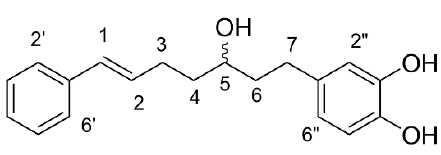
Figure1. Thechemicalstructureofcompound 1 Figure 1. The chemical structure of compound 1 (7-(3,4-dihydroxyphenyl)-5-hydroxy-1-phenyl-(1E)- 1-heptene) .